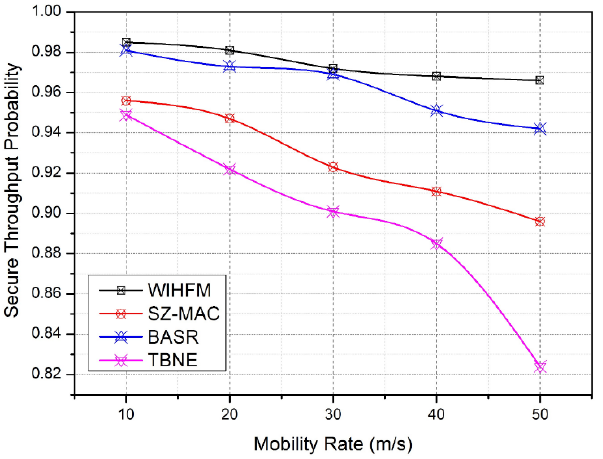
Figure 14. Secure Throughput Probability.